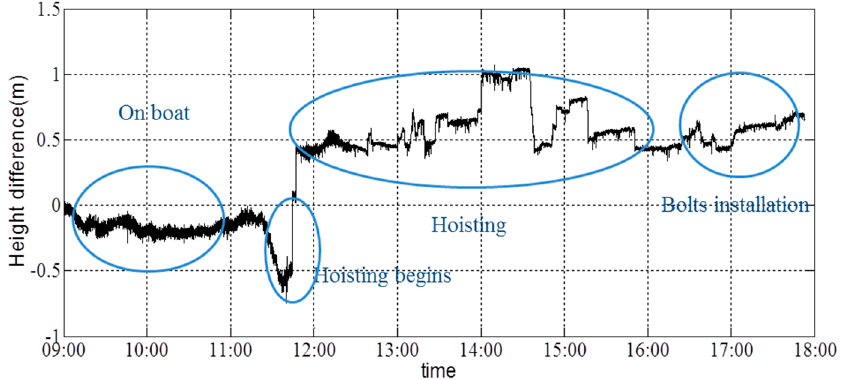
Figure 28. Height difference in the left/right direction.